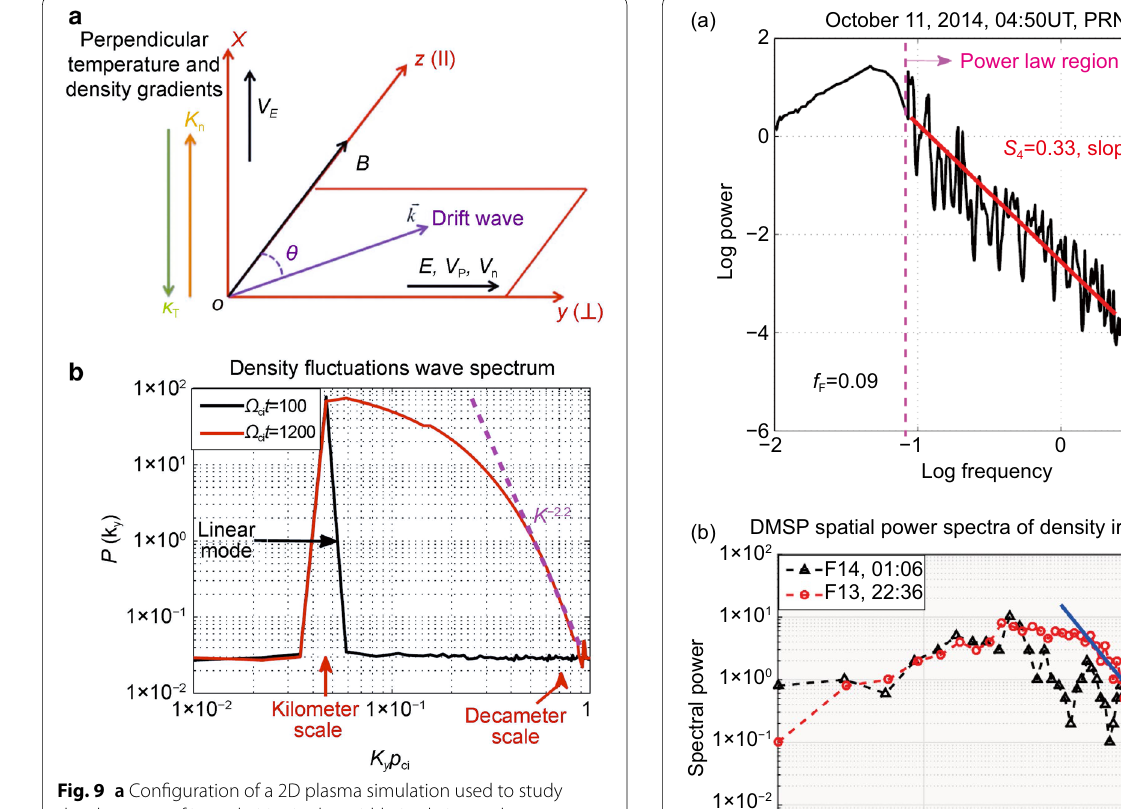
GNSS scintillation. Figure 10a shows the spectrum of GNSS scintillations during the periods of moderate mid-latitude GNSS scintillations (Eltrass et al. 2016). The power spectral index of the scintillation indicates − 2.8 an equivalent index of approximately f and Fresnel scale of 0.09 Hz. An important assumption on the sta- number spectra are equivalent. Figure 10b shows a typical irregularity power spectrum from the Defense Meteorological Satellite Program (DMSP) satellites F14 and F13 (Mishin and Blaunstein 2008) which is taken in a source region of GPS scintillations. Figure 10a − 2.2 ± 0.2 shows a power spectral index of k . It should